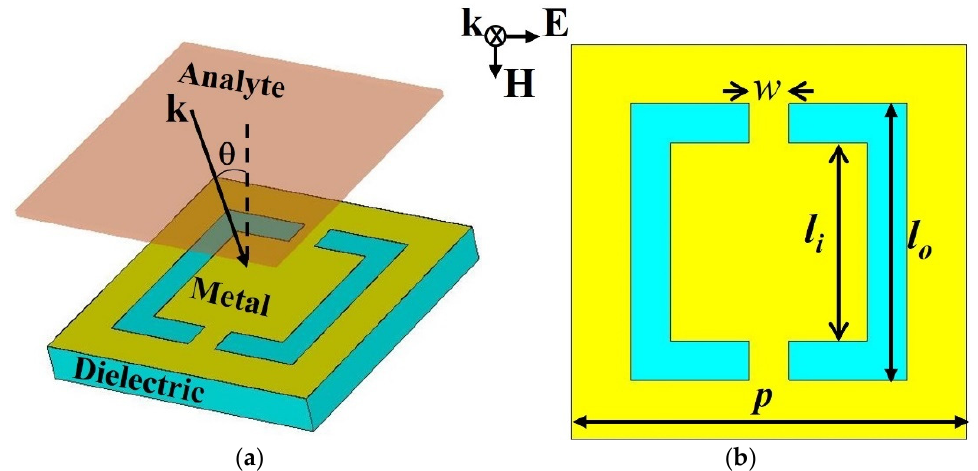
Table 1. The dielectric constant of the sample layer.